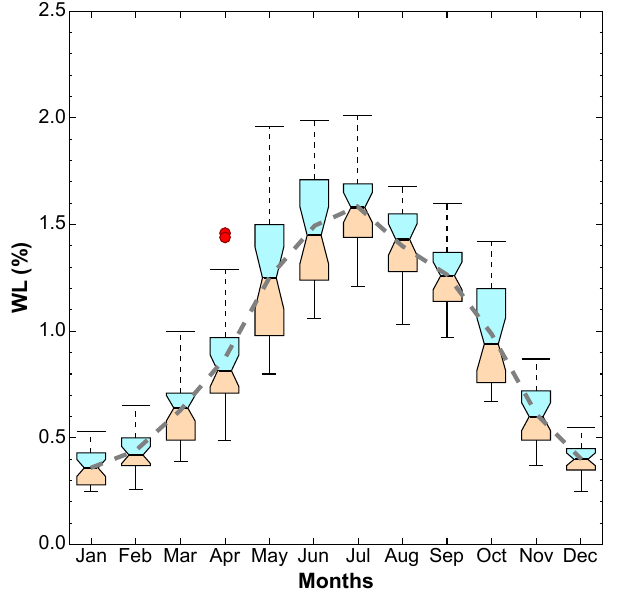
Figure 5. Notched boxplots show the daily variability of water loss for each month; the dashed line shows the mean value. Overall, the winter season (i.e., December, January, and February) shows lower water loss than other seasons and is characterized by low variability. In contrast, other seasons, particularly summer (i.e., June, July, August), represent the highest water loss and higher variability. Higher variability in water loss during the summer season indicates that temperature and solar radiation have an essential role in the evaporation rate during the day and among seasons [24]. During the summer season, the total water amount lost due to evaporation is estimated between 40 and 50% (Figure 6).